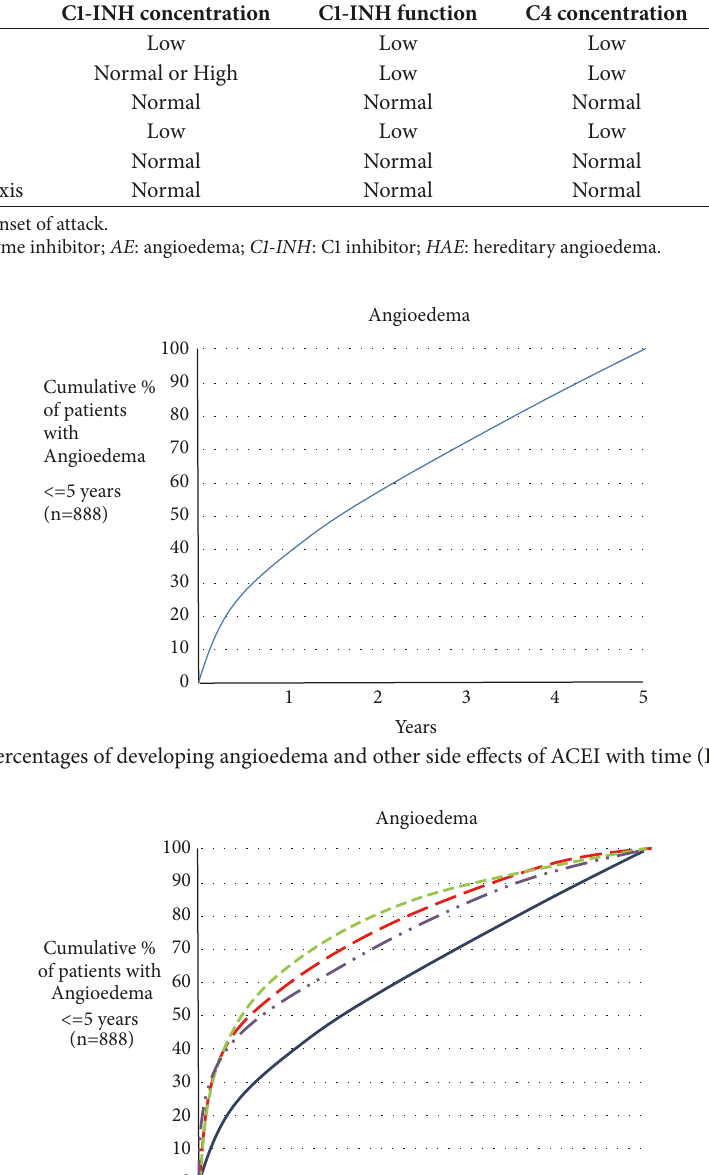
Table 1: Diagnostic tests to help distinguish among angioedema types (table reproduced from Bernstein JA et al. (2017), [under the Creative Commons Attribution License/public domain]).